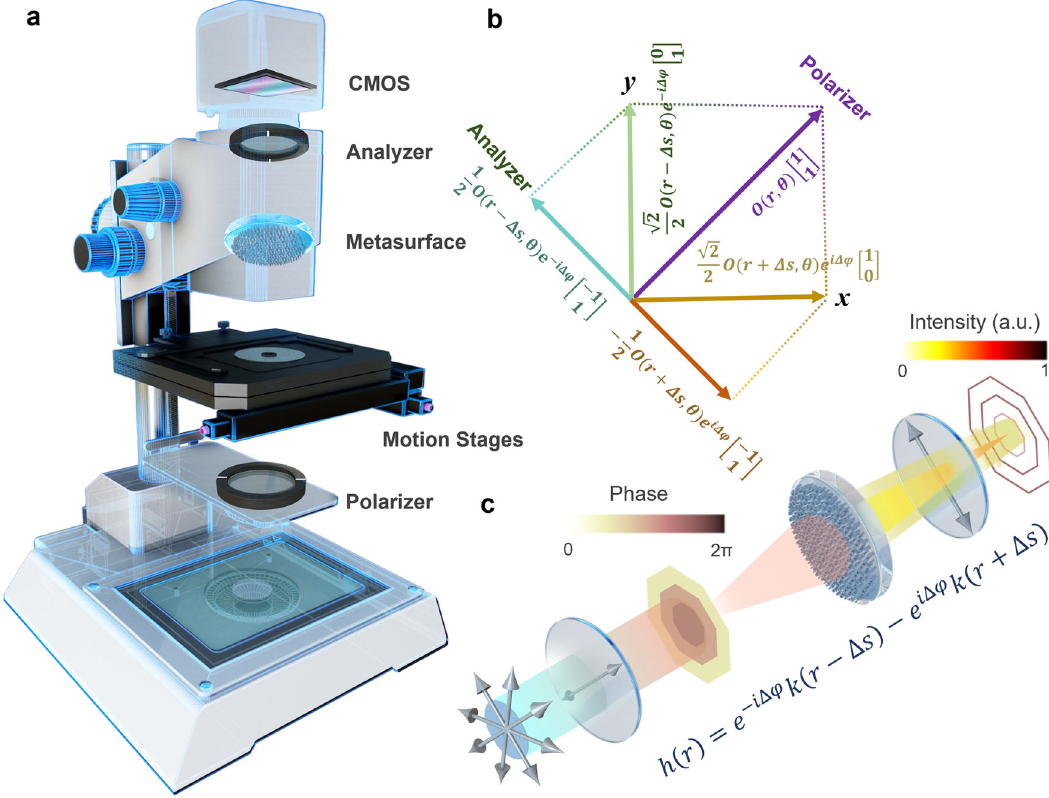
Fig. 1 | Principle of metasurface-assisted i-DIC microscopy. a The schematic of the proposed i-DIC microscopy. CMOS, complementary metal oxide semi- conductor. b the polarization conversion and optical fi eld changes in the